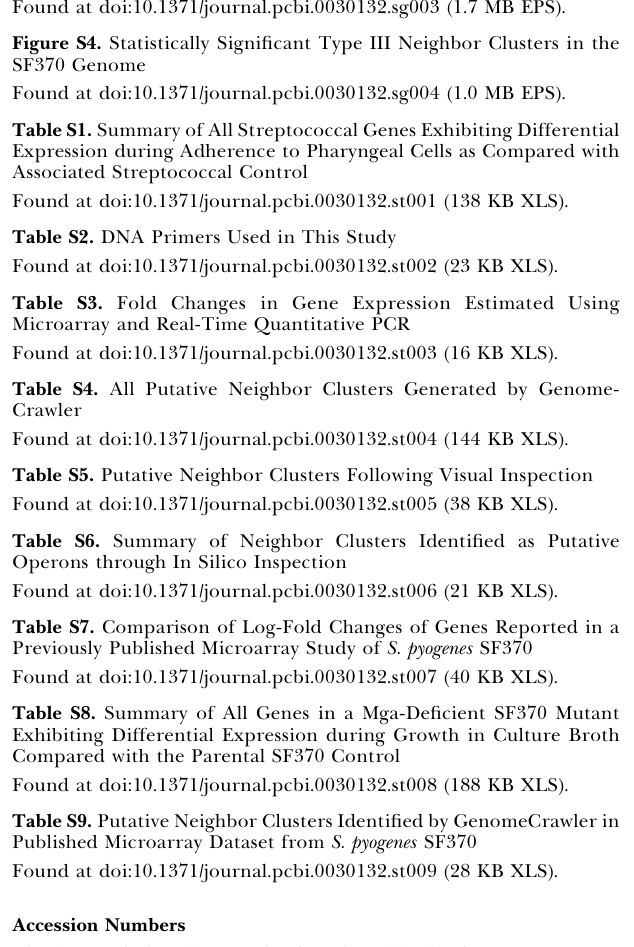
Figure S1. Comparison of Microarray and TaqMan Analyses Found at doi:10.1371/journal.pcbi.0030132.sg001 (876 KB EPS). Figure S2. Statistically Significant Type I Neighbor Clusters in the SF370 Genome Found at doi:10.1371/journal.pcbi.0030132.sg002 (1.7 MB EPS).